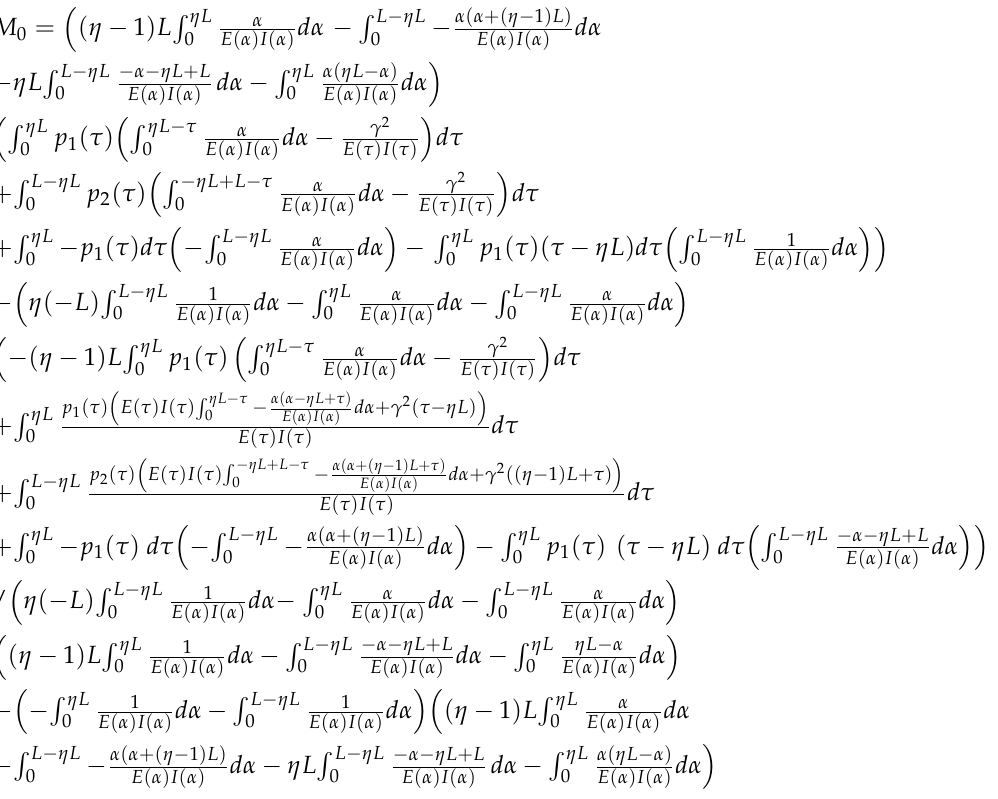
Figure 6. A fi xed beam with both ends subjected to the two di ff erent distributed loads.